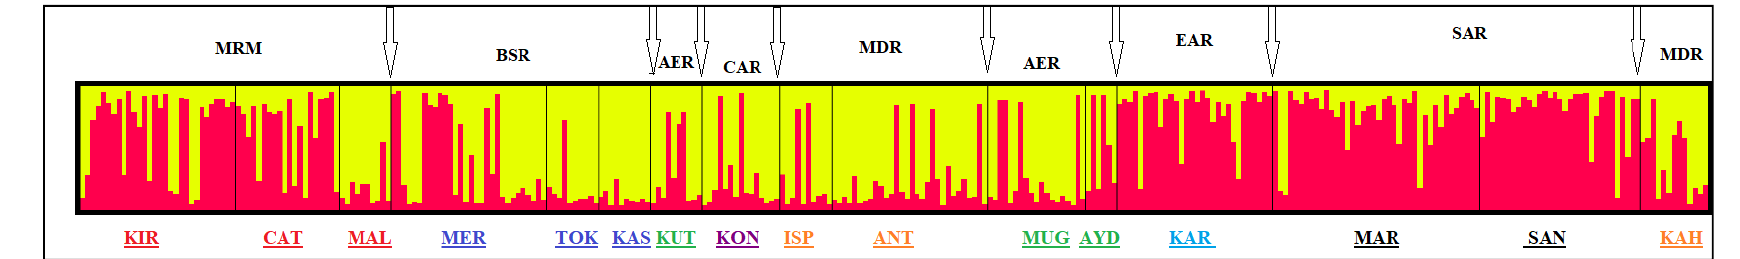
Figure 4. Clustering analysis by structure for the full-loci dataset assuming K = 2. Population name abbreviations are labeled below the structure result (Kırklareli—KIR,